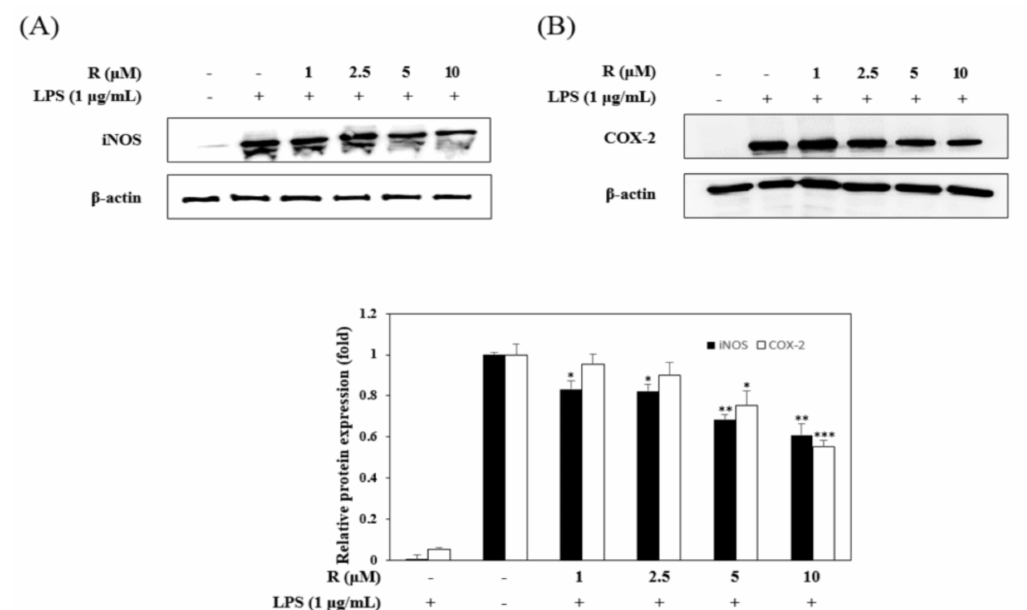
Figure 5. E ff ects of R on iNOS and cyclooxygenase COX-2 expression. RAW 264.7 cells were incubated in the presence of R for 1 h and then stimulated with LPS (1 µ g / mL) for 16 h. The expression of iNOS ( A ), COX-2 ( B ), and β -actin in the LPS-induced cells was determined by Western blot analysis. The relative density was calculated as the ratio of the level of each protein expressed to the level of β -actin.